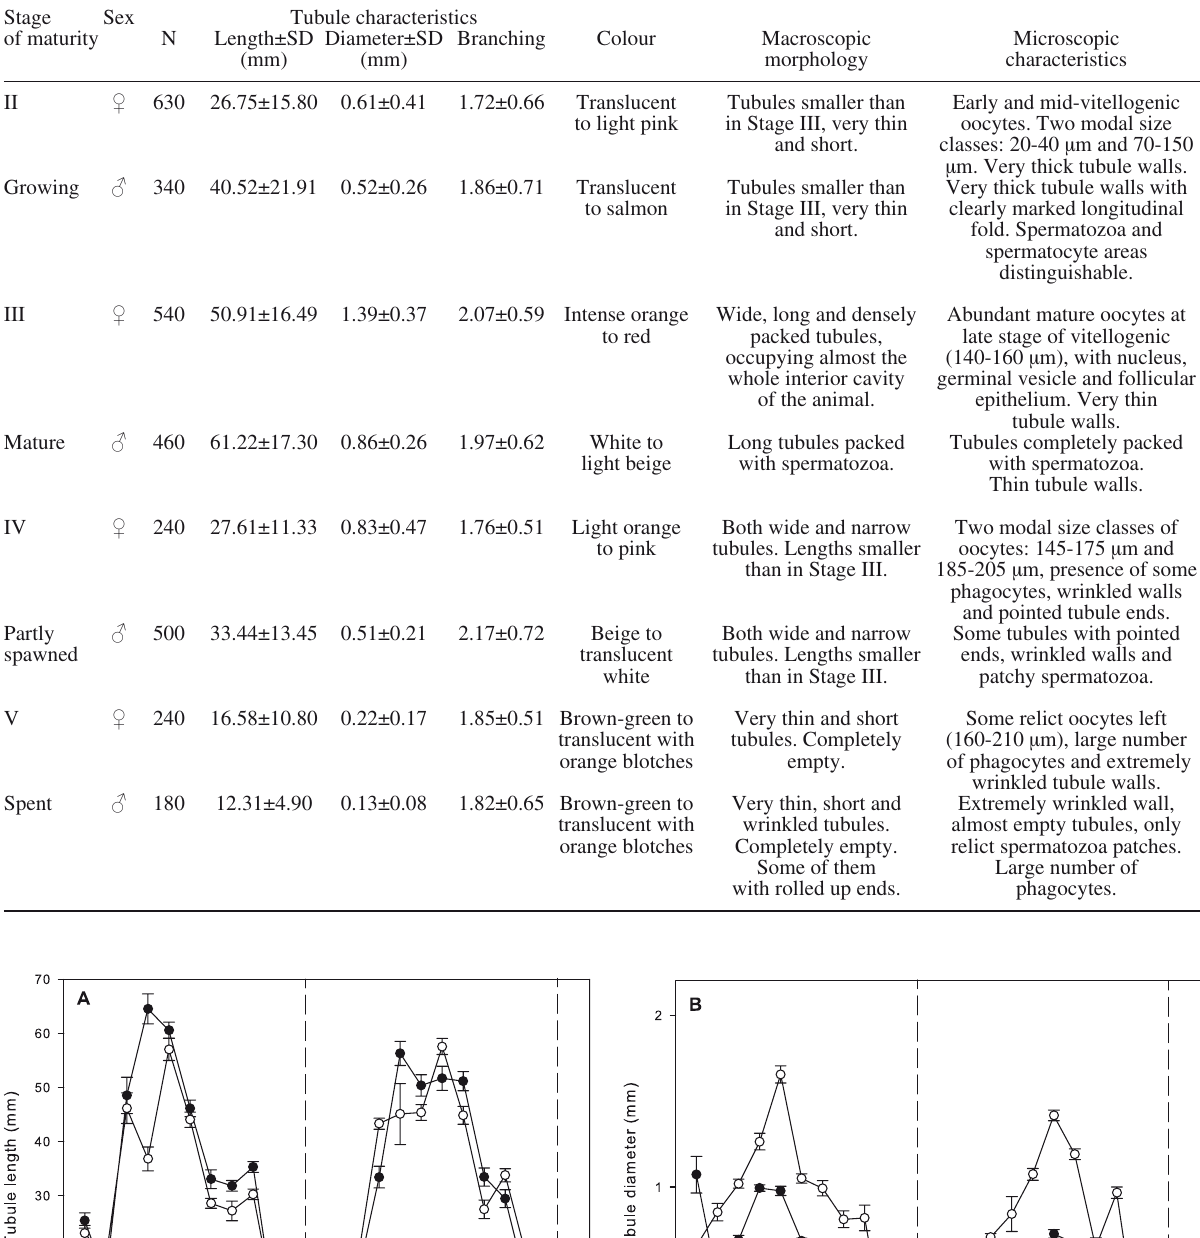
Table 3. – Macroscopic and microscopic characteristics of H. sanctori gonads at each of the stages of sexual maturity.